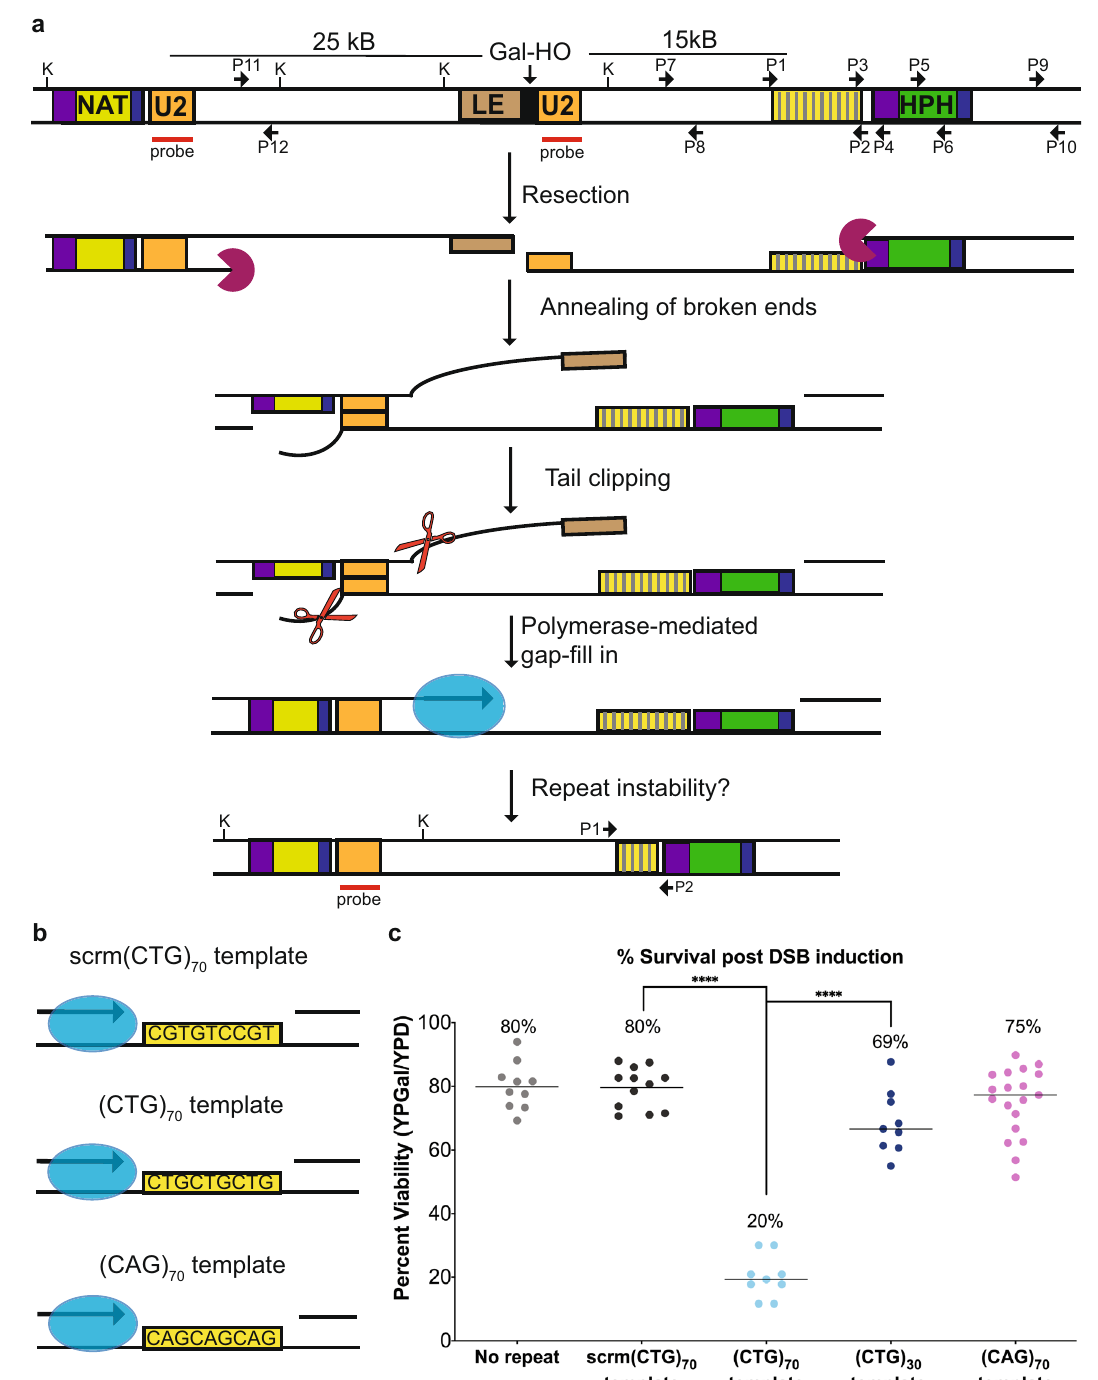
Fig. 1 | Identity of the repeat tract on the template strand determines survival post-DSBinduction.a AssaysystemtostudygaprepairmediatedCAG/CTGrepeat instability. Modifying strain YMV80 13 , we inserted a CAG/CTG repeat tract ~13kb centromere-proximal from an HO endonuclease cut site within LEU2 . Following